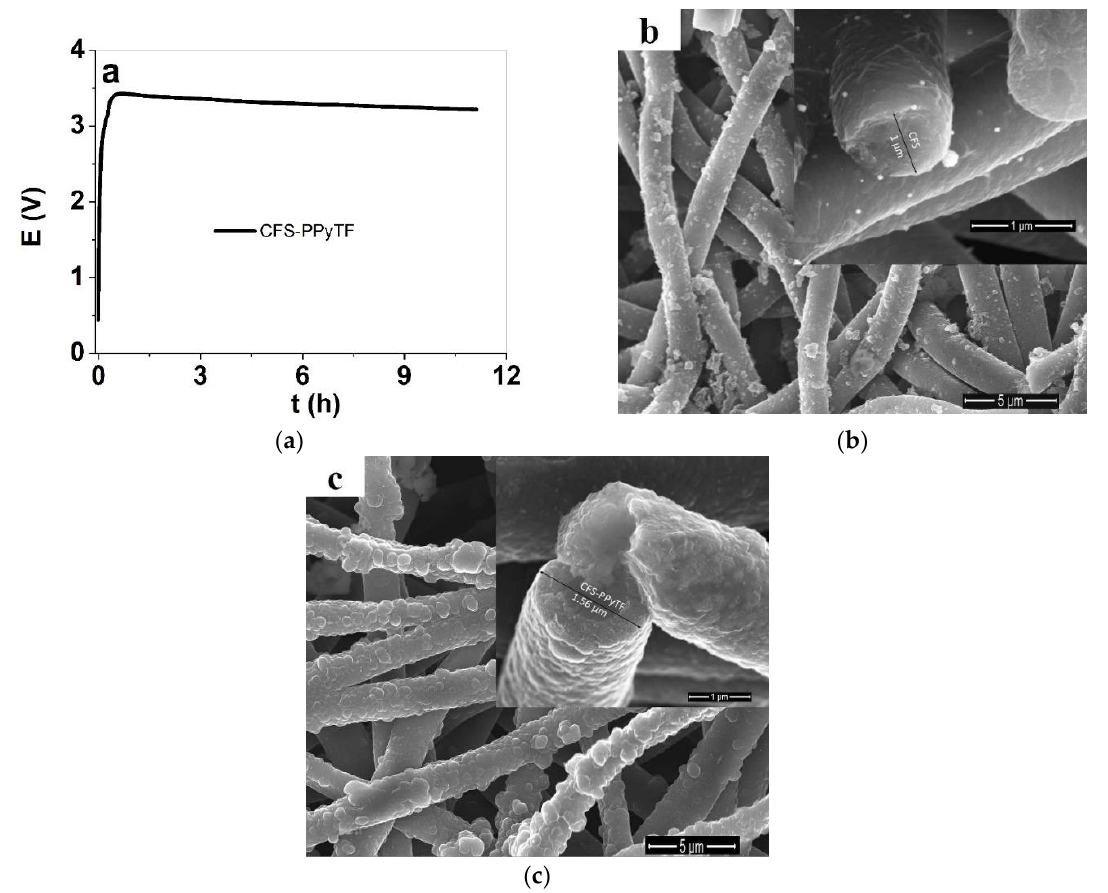
Figure 1. ( a ): Galvanostatic electropolymerization curve (0.1 mA cm −2 , −20 °C, 40,000 s, 0.1 M TBACF 3 SO 3 , 0.1 M Py, propylene carbonate) in two electrode cell (counter electrode stainless steel mesh and working electrode conductive fiber scaffolds (CFS)) of CFS-PPyTF. The scanning electron microscope (SEM) images (scale bar 5 µ m) with inset of single fiber (scale bar 1 µ m) of ( b ) CFS and ( c )